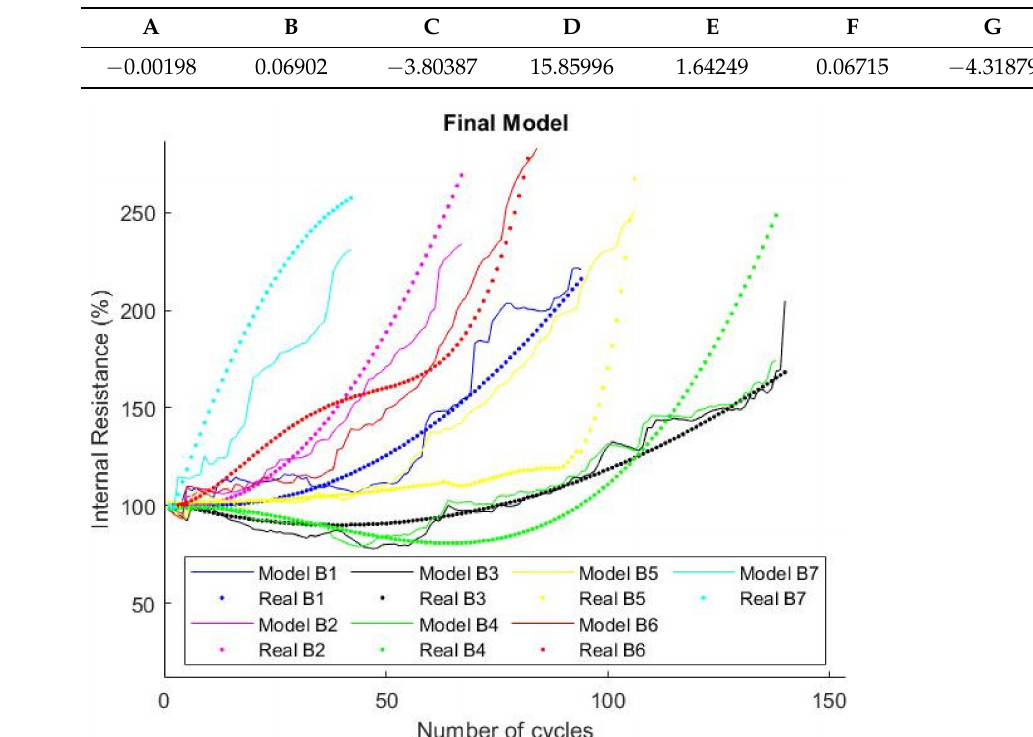
Table 3. Solution parameter results including batteries 1–7.